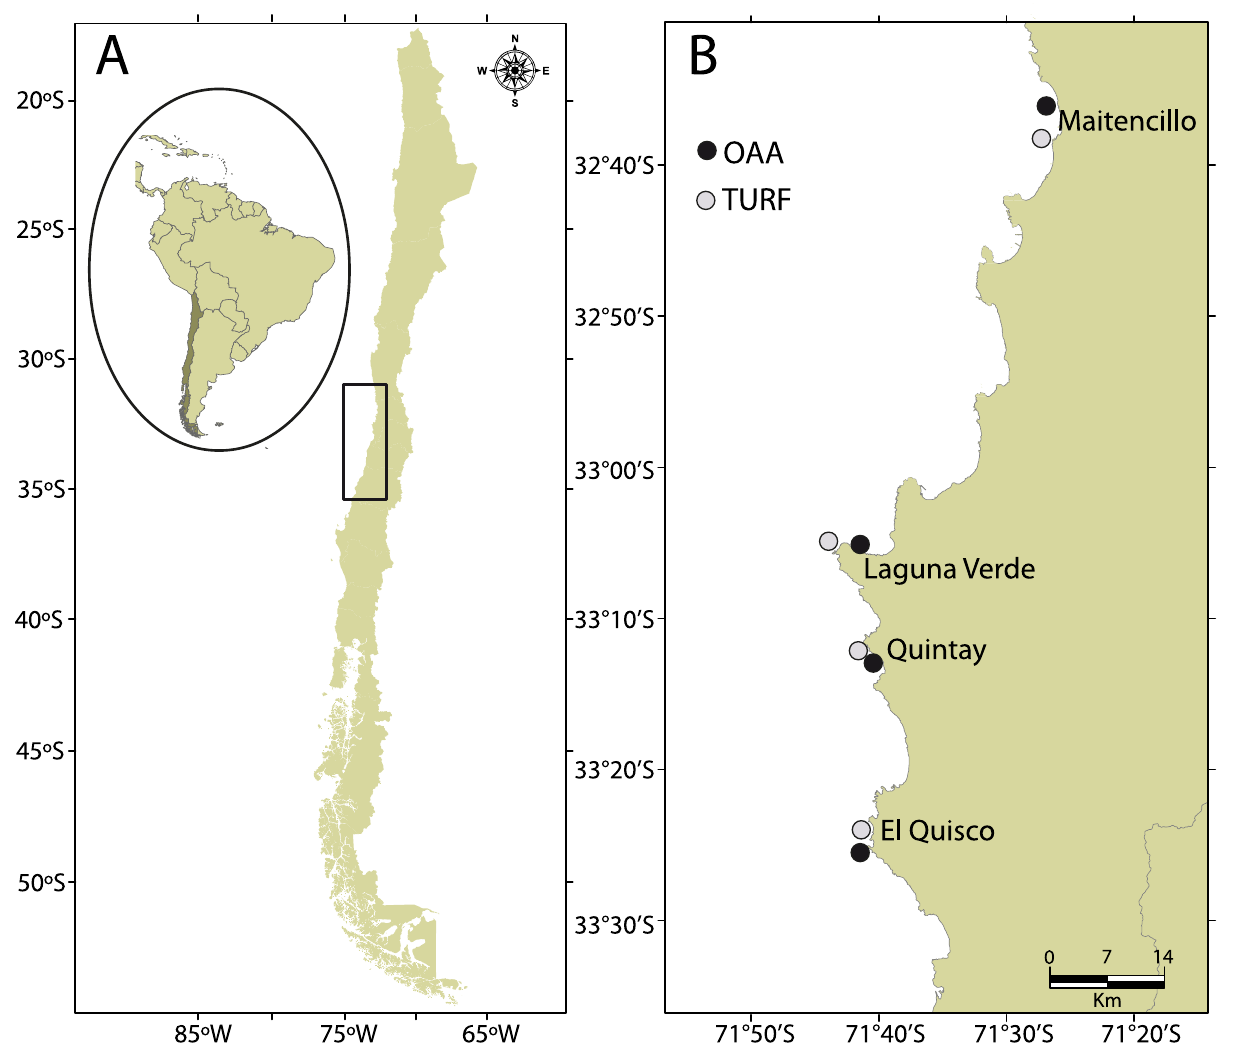
Fig 1. Map of the study area. Maps of Chileancoast showing(A) the study region and (B) the samplingsites where direct collectionof organisms was conducted. Fishing regimesare indicatedin black circles (Open Access Areas; OAAs) and gray circles (Territorial Use Rights for Fisheries;